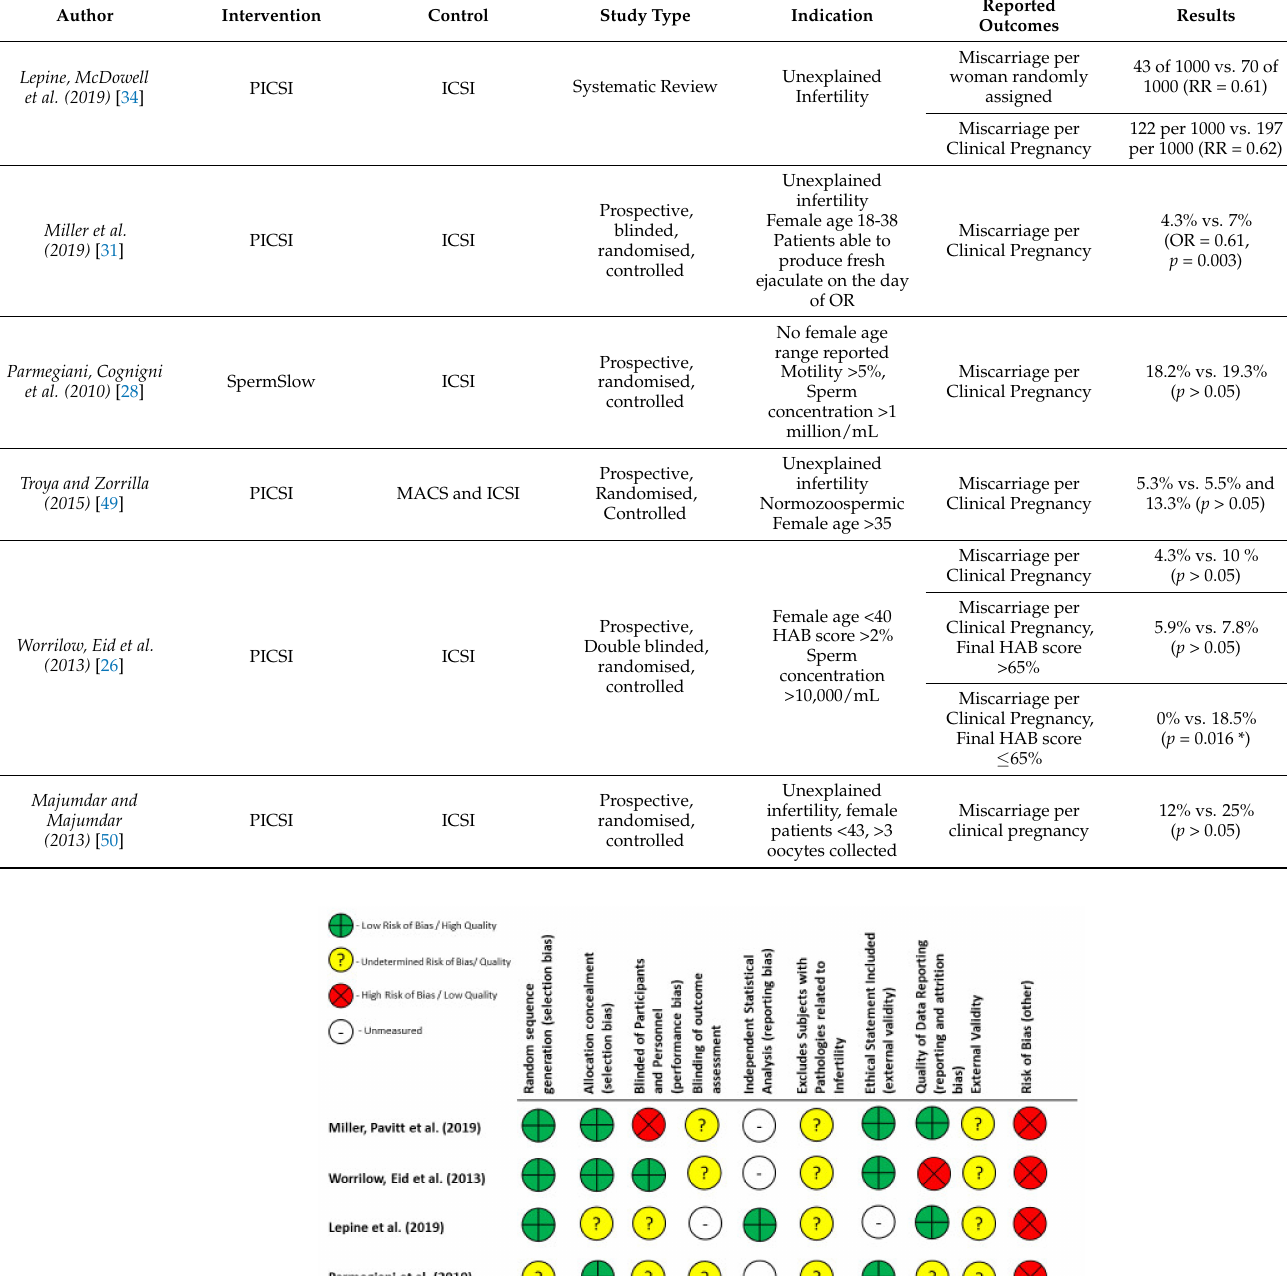
Table 2. A table summarising the studies included in this review for study question 2—Does sperm selection by HAB improve the rate of pregnancy loss in IVF or ICSI cycles? * Indicates a significant result ( p < 0.05). MACS—magnetic activated cell sorting. OR: Odds Ratio; RR: Risk Ratios.